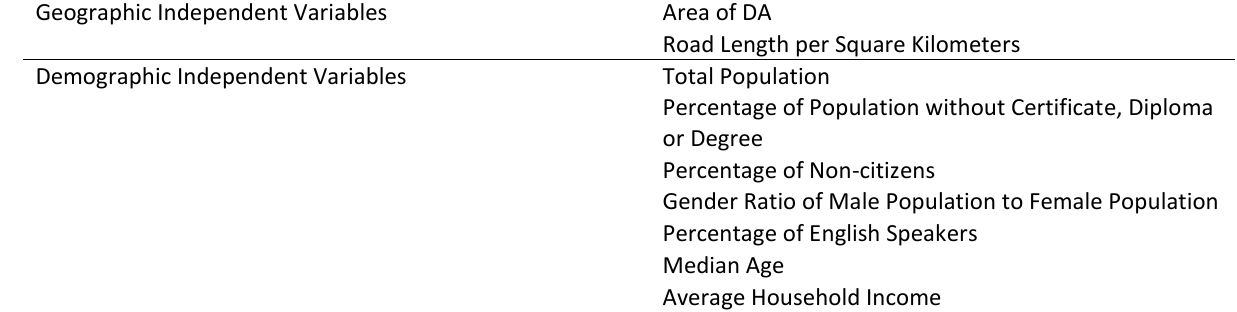
Table 2. Explanatory variables in regression models.